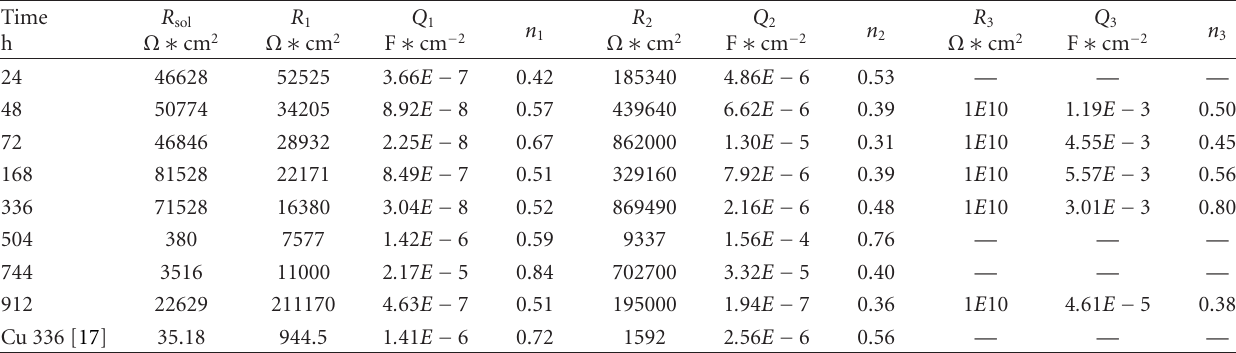
Figure 8: (a) Nyquist diagrams as a function of time of immersion and equivalent electric circuit and (b) electrochemical noise resistance- time series; for varnish-Ny-BTAH 20% sample. Table 2: Values obtained from the simulation of electrochemical impedance for polymer coating varnish-Ny-BTAH 20% sample as a function of